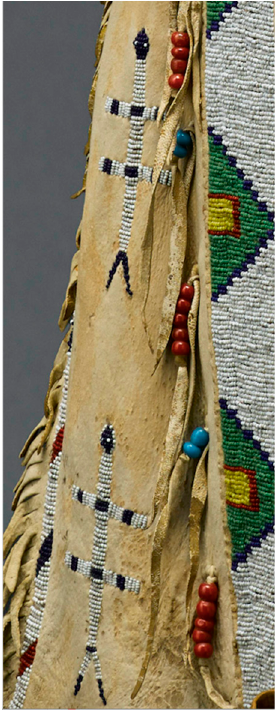
Figure 10. Regalia of It ȟ ú ŋ kasa ŋ Glešká (Detail of Figure 2a). Late nineteenth or early twentieth century. Buckskin and beadwork. Musée franco-américaine du château de Blérancourt. Photograph taken by Adrien Didierjean and used by permission of RMN-Grand Palais/Art Resource, NY.